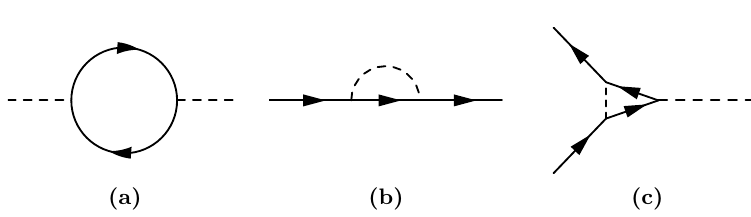
Figure 2. For the mixed dimensional Yukawa theory: (a) scalar one loop propagator correction; (b) fermion one loop propagator correction; (c) one loop vertex